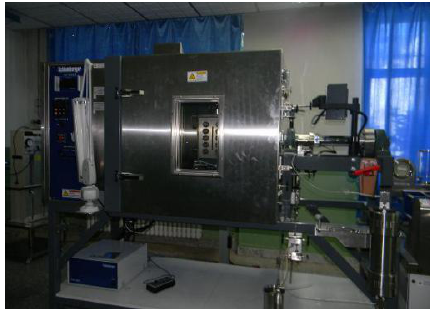
Figure 1. PVT experimental device.